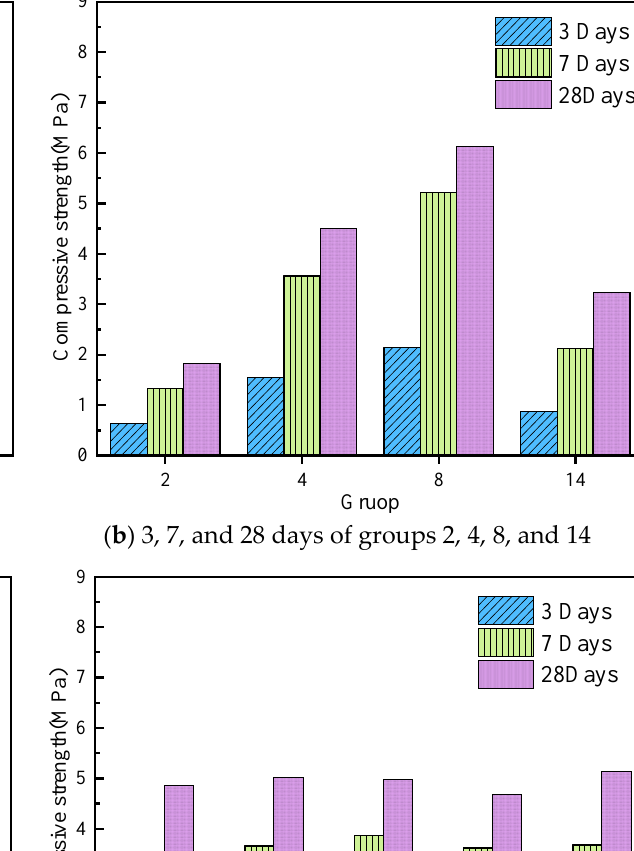
11 of 22 Figure 5. Viscosity of the slurry with different components. ( a ) Viscosity of groups 1, 3, 11, and 13; ( b ) Viscosity of groups 2, 4, 8, and 14; ( c ) Viscosity of groups 5, 9, 10, and 16; ( d ) Viscosity of 6, 7, 12, 15, and 17. 3.1.3. Unconfined Compressive Strength The slurry begins to condense and harden to form a stone body with a certain strength after being injected into the designated position. The key to the successful use of water plugging is the good stone body strength of the slurry. The strength of slurry stone bodies with different components after 3 days, 7 days, and 28 days of curing was meas- ured as shown in Figure 6. As can be seen from Figure 6, the strength of the specimen increases rapidly after 3 to 7 days of curing with an average growth rate of 159%. This was due to the consolidation of clay and hydration of cement after the specimen was formed. Different kinds of C-S-H gels and ettringites produced by C 3 A and C 4 AF improved the early strength of the specimen [34]. When the specimens were cured for 7 to 28 days, the strength of the stone body increased relatively slowly, with an average growth rate of 30.5%. The main reason for the further increase of the strength of the stone body was that the C-S-H gel formed by the reaction of C 3 S and water filled the pore structure of the consolidated clay. As can be seen from Figure 6a, when the W/C is 0.4, the amount of